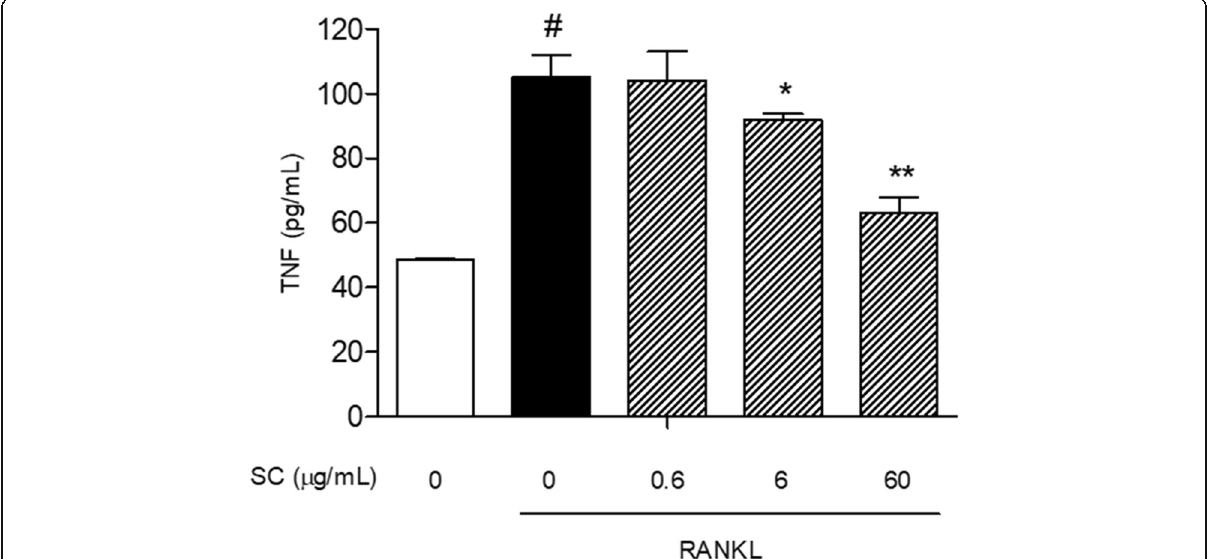
Fig. 2 The effect of SC on TNF- α secretion in RANKL-stimulated RAW 264.7 cells. RAW 264.7 cells (8 × 10 4 per well) were incubated with 100 ng/ mL RANKL or both RANKL and SC (0.6, 6 and 60 μ g/mL). After 7 days, the supernatant was collected and centrifuged. Total TNF- α concentration was calculated by ELISA. Data are represented as the means ± S.E.M. of three independent experiments. # p < 0.05 compared with non-treated cells. * p < 0.05 and ** p < 0.01 compared with only RANKL-treated